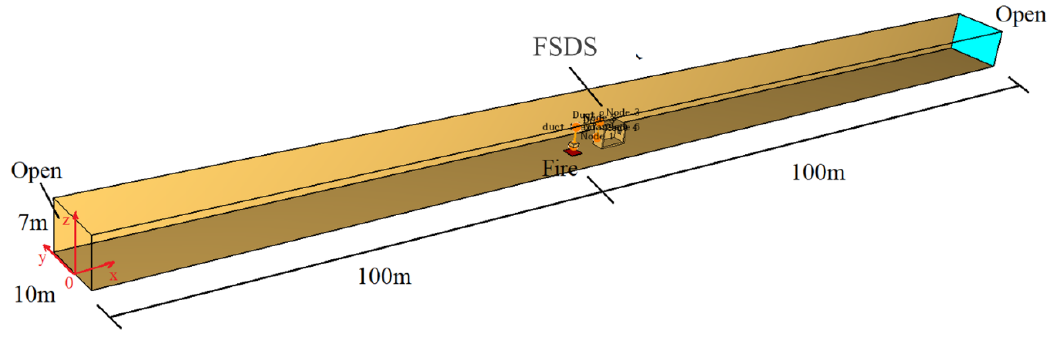
Figure 5. The sketch of the simulation model for the FSDS operation process in rectangular tunnel. Table 5. List of the measured fire environment parameters.